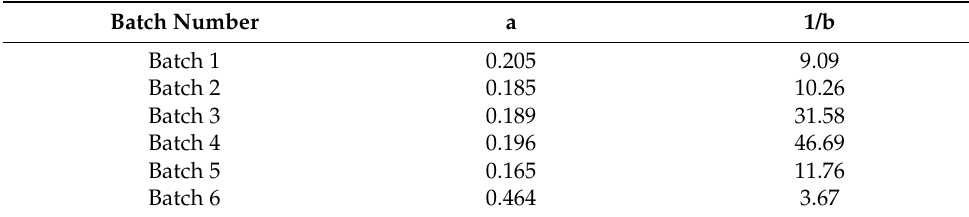
Figure 2. Behavior of co-processed excipients during packing N/C vs. number of taps. The Kawakita’s constants a and b for each of the excipients evaluated are listed in Table 2. In terms of the “a” constant, a higher value is related to poor flowability, being batch 6, with the highest compressibility value of 0.464, exhibited the lowest flowability. The other batches showed “a” value between 0.165 and 0.205, batch 1 presented the highest “a” value. The cohesive force was related to the constant 1/b, where lower values showed less cohesive force. The most cohesive excipients were batches 3 and 4. The results obtained by and Hausner index. Table 2. Kawakita’s constants.